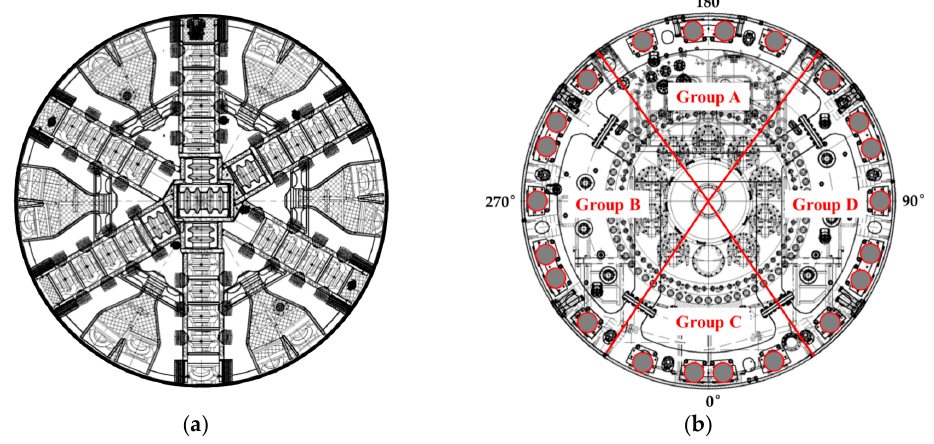
12 of 19 Figure 15. Geotechnical profiles of Ring 504. γ , weight density; ω , water content; K 0 , later pressure coefficient; c , cohesion; φ , internal friction angle; K v , vertical foundation coefficient; K h , horizontal foundation coefficient. 4.2. Shield Details An earth pressure balanced shield (EPB) machine of 6.68 m in diameter was used to excavate in Jinan Metro Line R2. The length of shield is 9 m, and its weight is about 500 t. Cutter opening ratio is 35%, as shown in Figure 16a. The shield machine specifications are summarized in Table 2. The shield